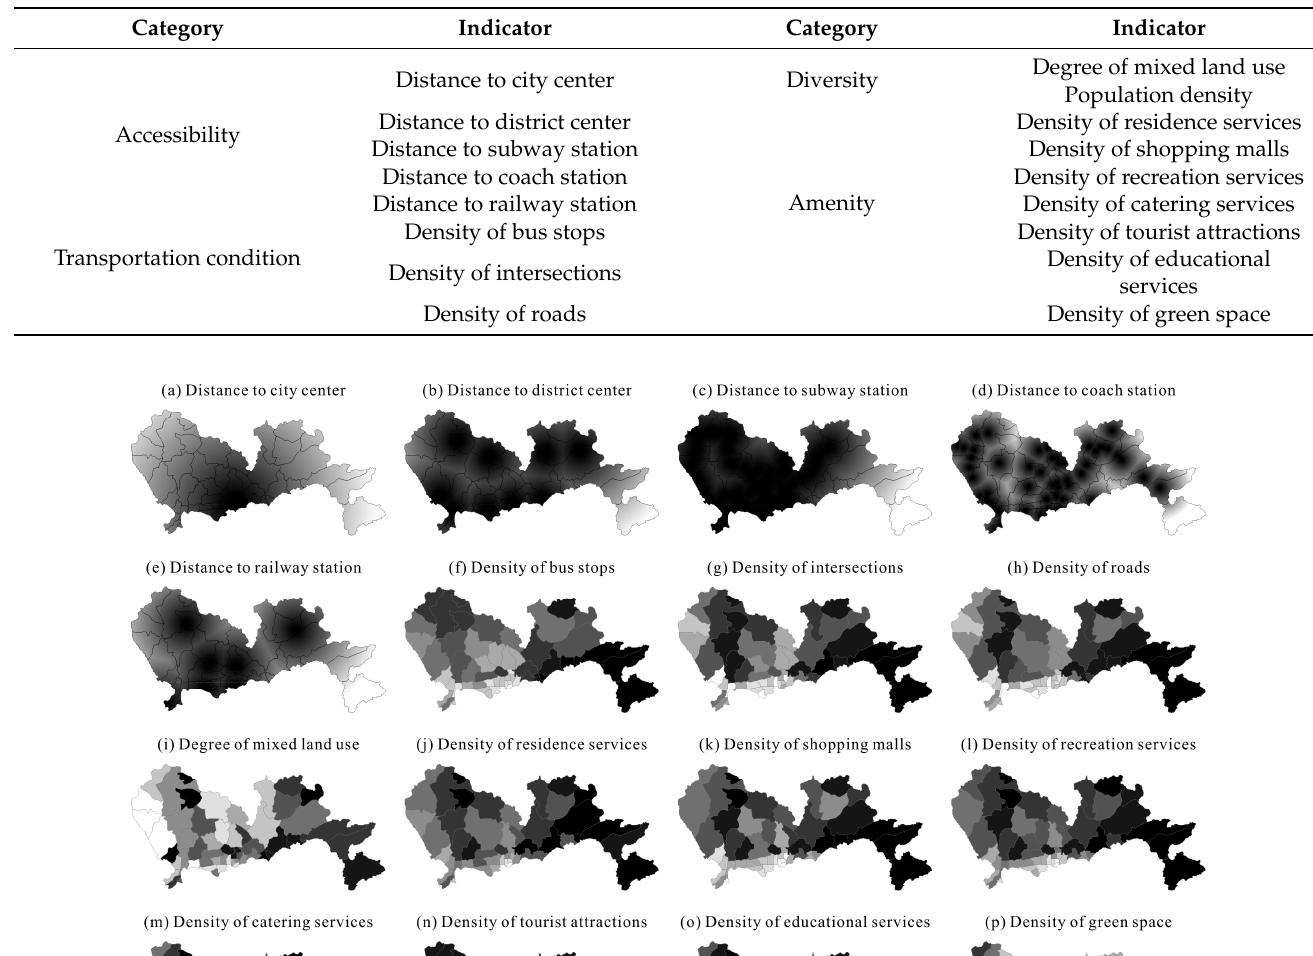
Table 2. Information on benchmark spatial drivers behind urban vitality.